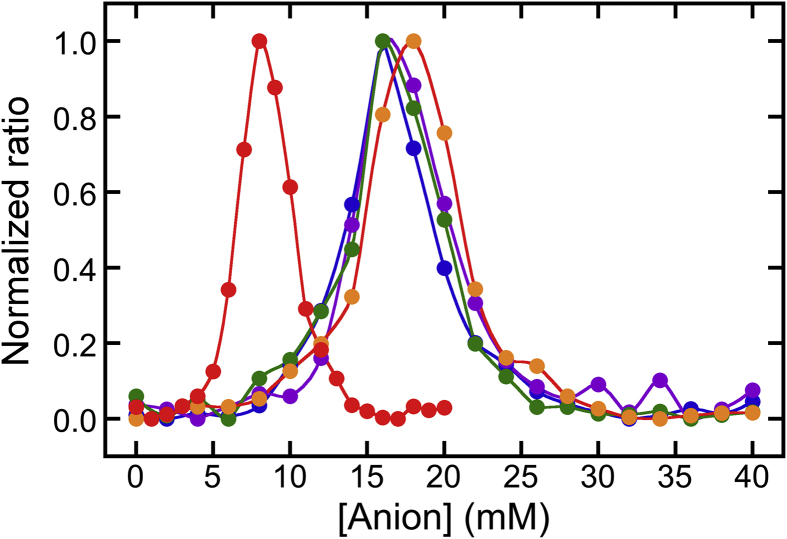
Comparison of the urea-soluble protein concentration observed with different Mg salts. The normalized ratios were calculated based on the concentrations of urea-soluble proteins shown in Fig. 1, using Eq. (1). The ratio was plotted against the anion concentration. The concentration of monovalent anions (Cl−, Br−, NO3−, and ClO4−) was calculated as double that of coagulants (MgCl2, blue circles and line; MgBr2, green circles and line; Mg(NO3)2, purple circles and line; and Mg(ClO4)2, orange circles and line, respectively). The MgSO4 concentration was equivalent to that of the divalent anion SO42− (red circles and line).